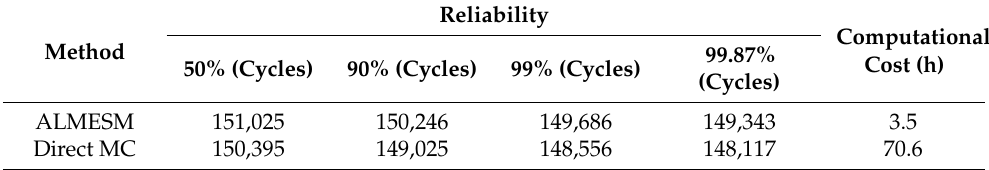
Table 6. The typical life–reliability results.